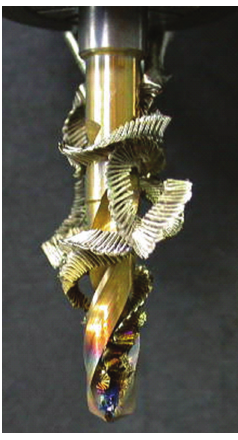
Figure 6: Tool blocking caused by the accumulation of material in the chip flow